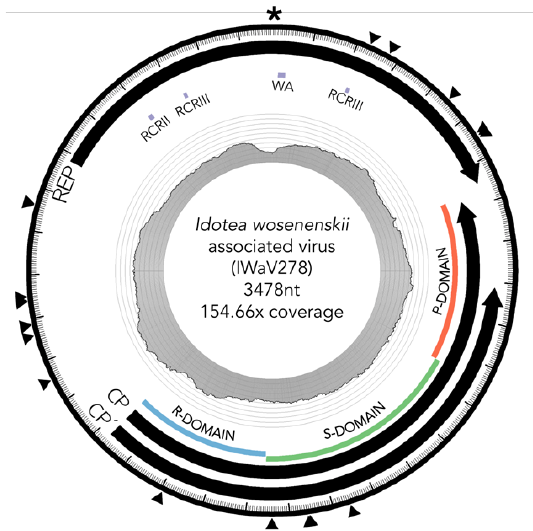
Figure 1. Diagram of IWaV278 genome. Scaled depiction of chimeric virus IWaV278 exhibiting type III genomic architecture [12]. Annuli from the center: (i) line graph represents coverage per site; (ii) grey tiles indicate the position of rolling circle Rep motifs RCRII (LHLQG) and RCRIII (YCRK and YALK), Rep-associated Walker-A motif (WA: GSTGTGKS), and Cp domains R (RNA/genome- interacting), S (shell), and P (protruding); (iii) black arrows denote Rep, Cp, and Cp’ ORF size, and orientation; (iv) external arrows indicate substitution sites; (v) the asterisk denotes position of the putative ori (nonanucleotide motif: TAATATTAC). Genome visualized via Circos (v.0.69-3; [47]).